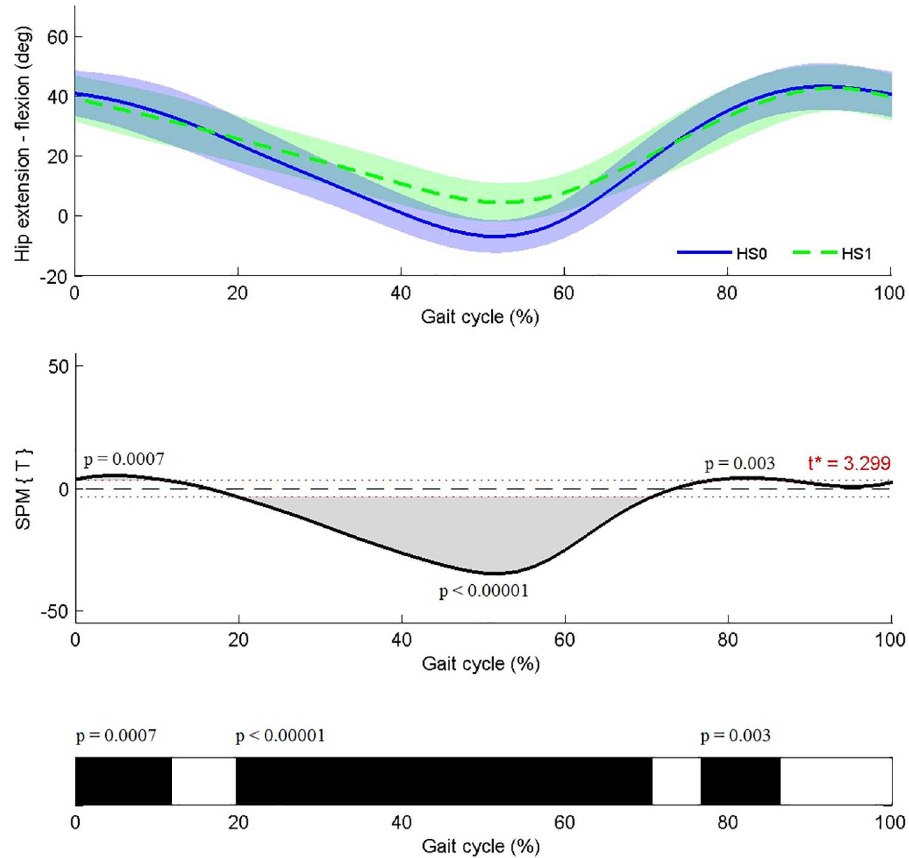
Fig 1. Example of summarizedpresentation of SPM results. Upper graph shows the mean kinematic hip angle in the sagittal plane of trials classified as ‘no or minor gait deviations’ (HS0) or ‘hip extensiondeficit’ (HS1). Middle graph shows SPM {t} statistic as a function of the gait cycle. The critical threshold (t * ) was exceededbetween0–12%,20–71%,and 76–86%of the gait cycle. Lower black bars represent a simplified visualizationof the significantareas indicatedby the SPM{t}